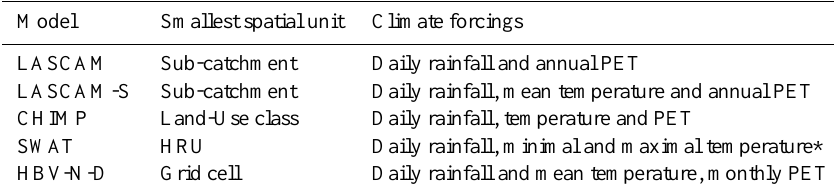
Table 1. Main model characteristics.